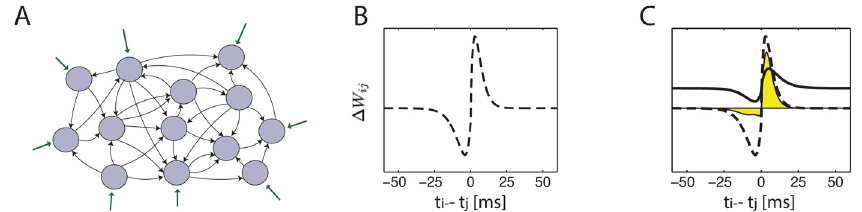
Fig 2. A. Illustration of the network architecture. The network contains recurrently connected neurons that receive a constant external input. B. Example of an STDP function. Horizontal axis: time interval between action potentials in the pre and post synaptic neurons. Vertical axis: change in synaptic efficacy. C. The drift of the STDP dynamics is an integral over the product of the correlation and STDP functions. Black line: time dependent correlation. Dashed line: STDP function. The area under the product of these curves (yellow) determines the synaptic drift.